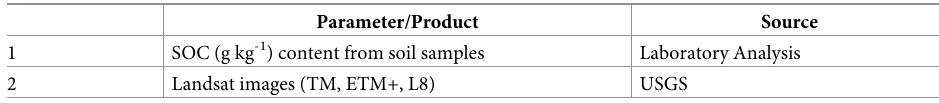
Table 2. Inputs used for the development of SOC prediction